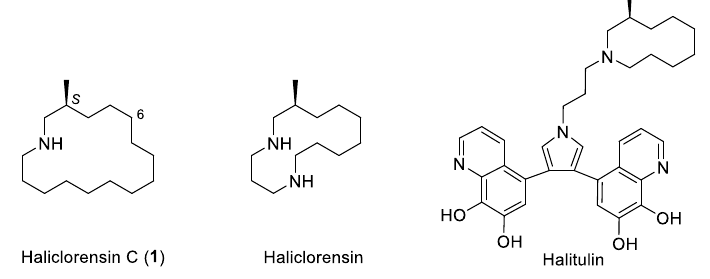
Figure 1. Azamacrocyclic marine alkaloids isolated from Haliclona tulearensis . Molecules 2019 , 24 , 1069;